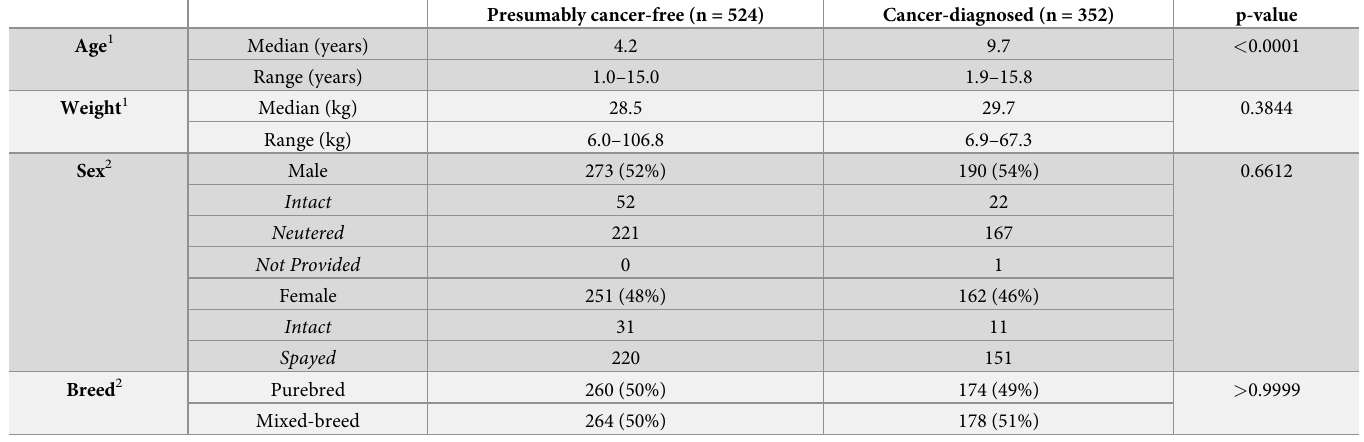
Table 2. Demographics of presumably cancer-free vs. cancer-diagnosed subjects in the testing